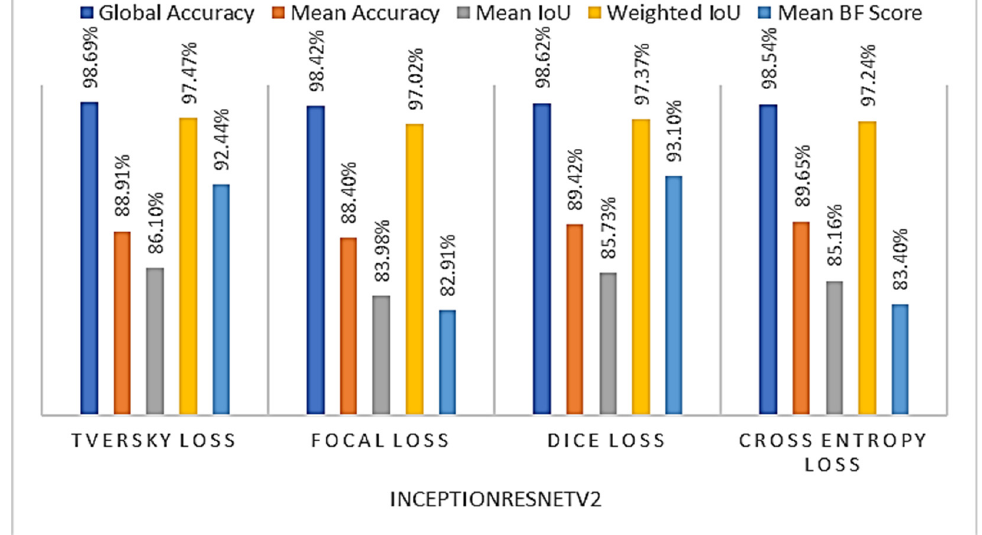
Figure 6. The overall metrics were gathered using different loss functions with Deeplabv3+ with InceptionResNetV2 as a backbone.